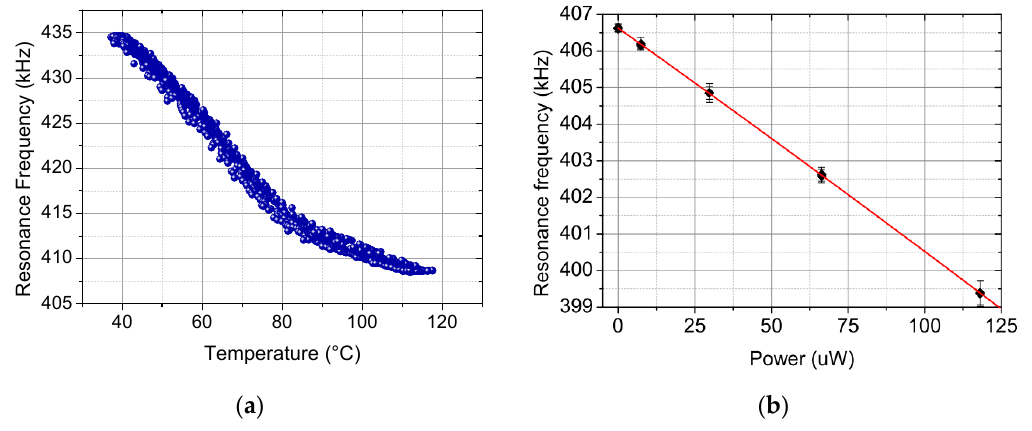
Figure 3. Resonance frequency (first flexural mode) of a LSMO bridges of dimensions 150 × 15 × 0.3 μ m 3 measured in ambient pressure conditions as a function of ( a ) external temperature (cycle ≈ 100 °C → 40 °C → 120 °C in about 12 min); ( b ) dissipated Joule power calculated as I 2 × R, where R is the electrical resistance probed across the microbridge by four probe method. Linear fitting function is reported in red. Sample stage is kept at ambient temperature.